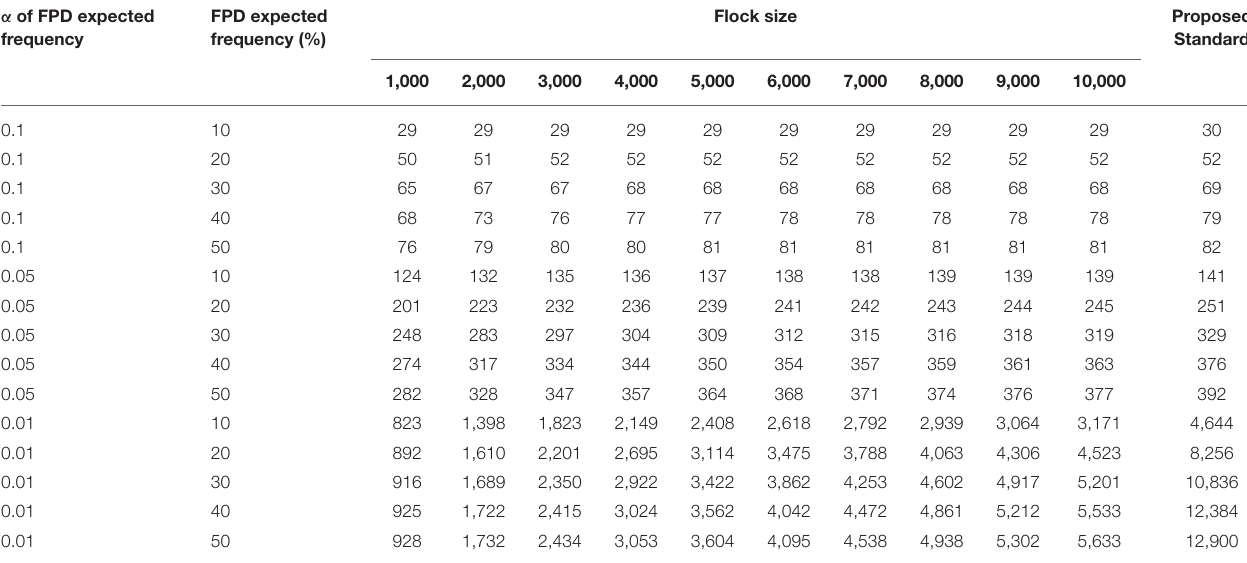
TABLE 2 | Calculated number of birds to be monitored and evaluated depending on flock size, prevalence of footpad alterations, confidence interval ( α 0.1 = 90%, 0.05 = 95%, and 0.01 = 99%, respectively), and proposed standard. α of FPD expected